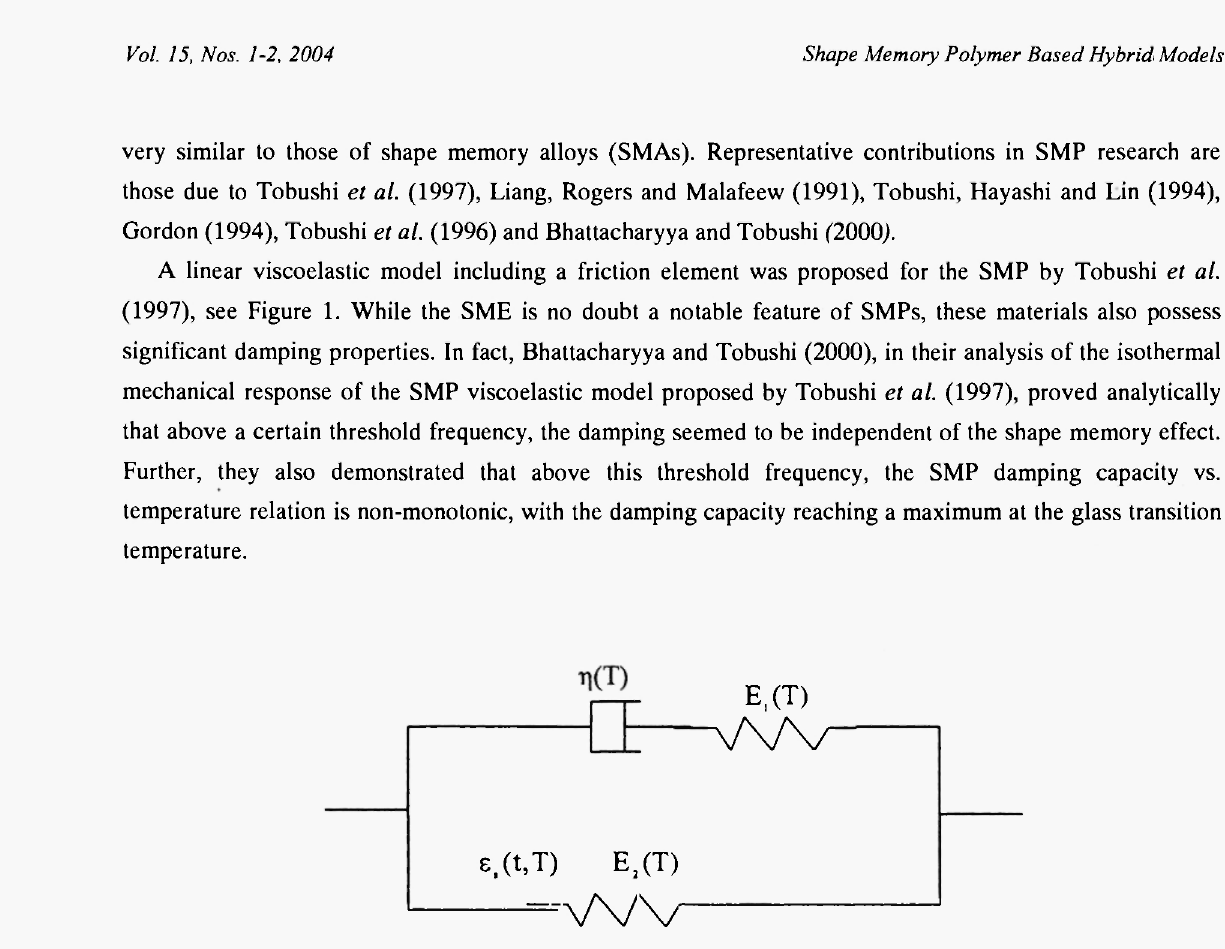
Fig. 1: The schematic of the shape memory polymer (SMP) rheological